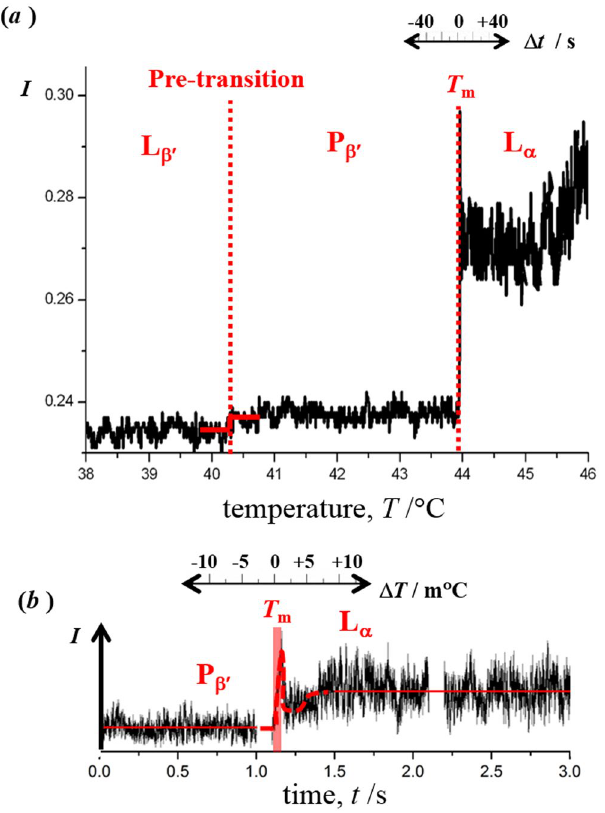
Figure 1. An optically-trapped DPPC liposome. ( a ) The back-scattered intensity at 1070 nm. ( b ) The back- scattered intensity of light at 488 nm measured, with high temporal resolution, across the main transition, L β′ → L α . The horizontal red line shown in ( b ) represents the average intensity signal across the time